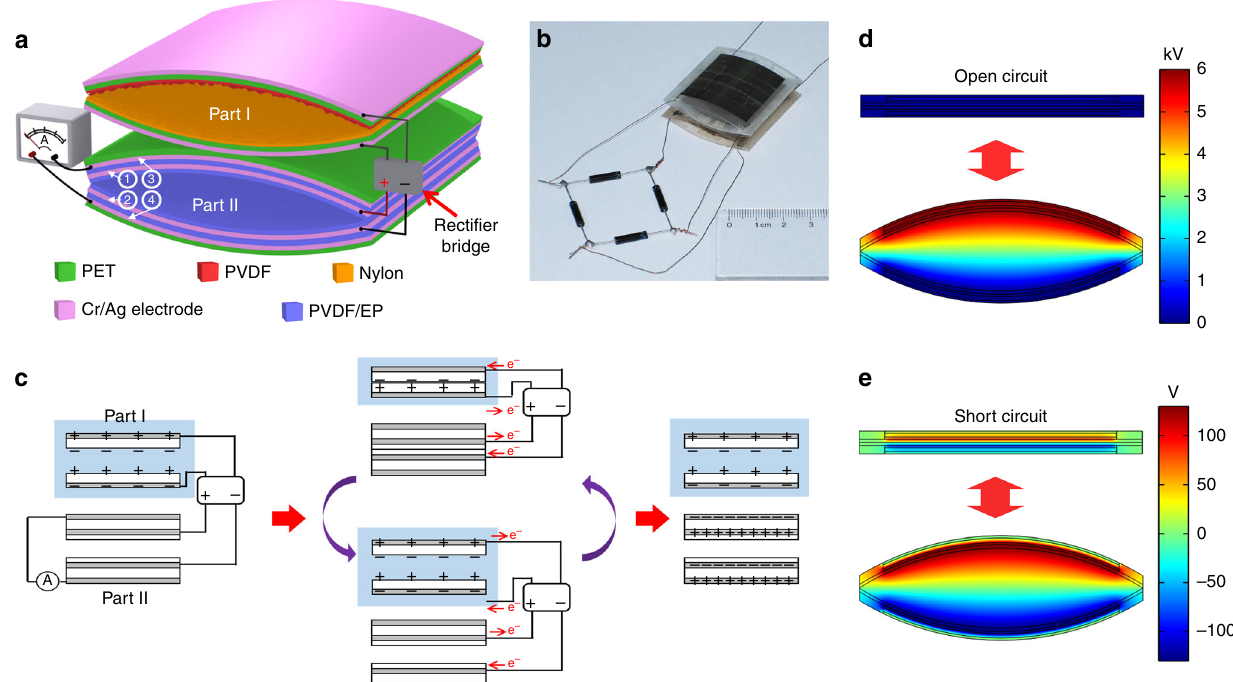
Fig. 1 Design, structure, and working mechanism of the self-improving triboelectric nanogenerator. a Schematic diagram of the self-improving triboelectric nanogenerator (SI-TENG) composed of polyethylene terephthalate (PET), polyvinylidene fl uoride (PVDF), and PVDF/epoxy resin (EP). b Optical image of a SI-TENG. c Charge accumulating process of the SI-TENG and corresponding charge transfer direction in the circuit. The friction layers in part I are replaced by positive and negative charges, and the PET fi lm in part II are not shown in the image. d , e Simulation results of potential distribution in part II in the open- circuit ( d ) and short circuit ( e ) condition with the gap distance changes between 0 and 340 μ m, and the charge density of 300 μ C m − 2 in the plane-parallel capacitor structure